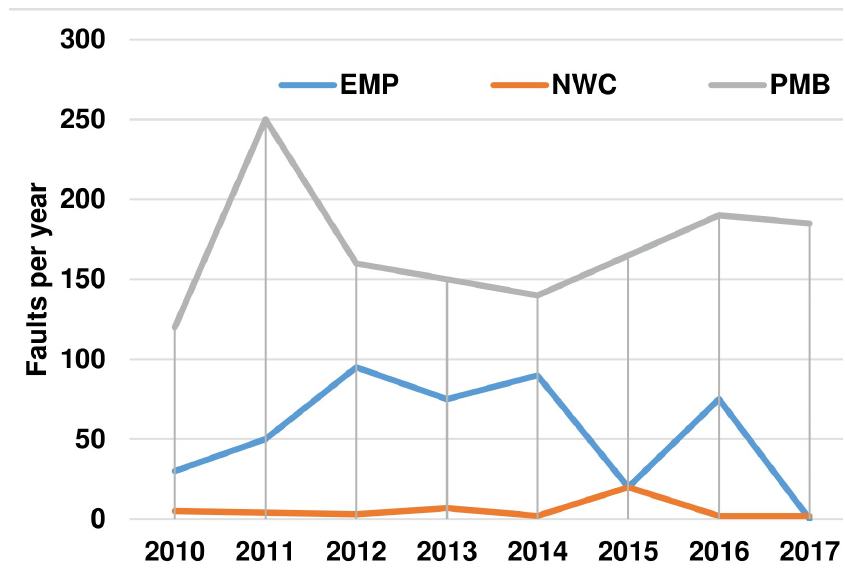
Figure 2. Overview of line fault in KZN zones between 2010 and 2017. [Source: Eskom]